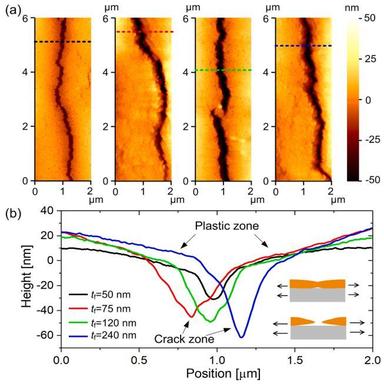
Evidence for ductile fracture mechanism of Cu film. a) AFM images showing surface morphology near the crack tip for different film thickness, from left to right, tf=50, 75, 120 and 240 nm, respectively. b) Surface profile measured at the position coded with dotted lines in a). Near the cracks, the profiles present slopes, indicating the plastic zone here due to the typical necking process of a ductile material. The inset illustrates the development of a crack in a ductile thin film material by tensile load.